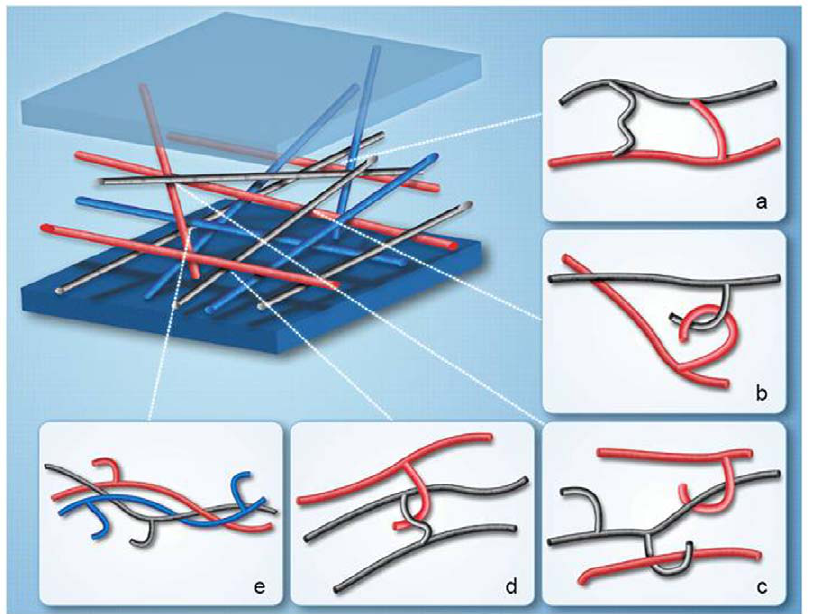
Figure 8. Conceptual model of the role of (1 R 6)- b -linked glucosyl side chains in the fungal cell wall structure. Possible arrangements of (1 R 6)- b -D-glucan branches within the glucan matrix include (a) direct covalent cross-linking between two (1 R 3)- b -linked polymers, or (b) non- covalent interactions by ‘‘hooking’’ across (1 R 6)- b -linked side chains, or (c) across (1 R 3)- b -linked polymers, or (d) ‘‘catching’’ a covalent (1 R 6)- b - linked cross-linking branch. The triple helix arrangement (e) with associated (1 R 6)- b -linked side chains may serve as points for attachment to chitin, mannan, mannoprotein, GPI protein anchor or other possible molecules.